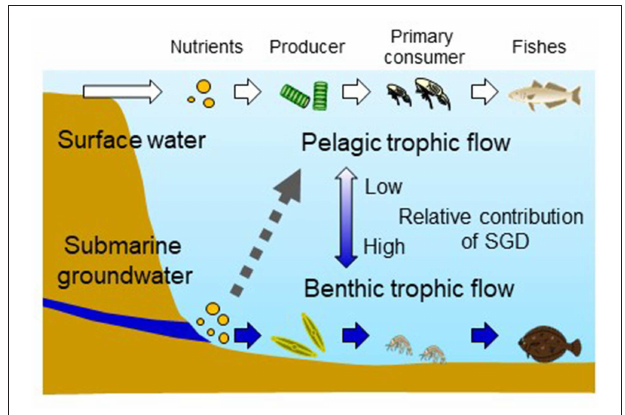
FIGURE 6 | A schematic drawing of contribution of nutrients provided by surface (river) water and SGD to pelagic and benthic trophic flows of coastal waters. Contribution of nutrients of SGD origin to the pelagic trophic flow has been still unknown or underestimated due to mixing of water and nutrients (indicated by an arrow with a broken line). Relative contributions of surface water and submarine groundwater are considered to be higher to the production of high-order ecosystem organisms of pelagic and benthic trophic flow, respectively. The contribution of nutrients of SGD origin to both pelagic and benthic trophic flows is assumed to be higher in an area where the influx of surface water is minimal and water mixing by tide prevails such as in the survey site III (Seto Inland Sea) in the present